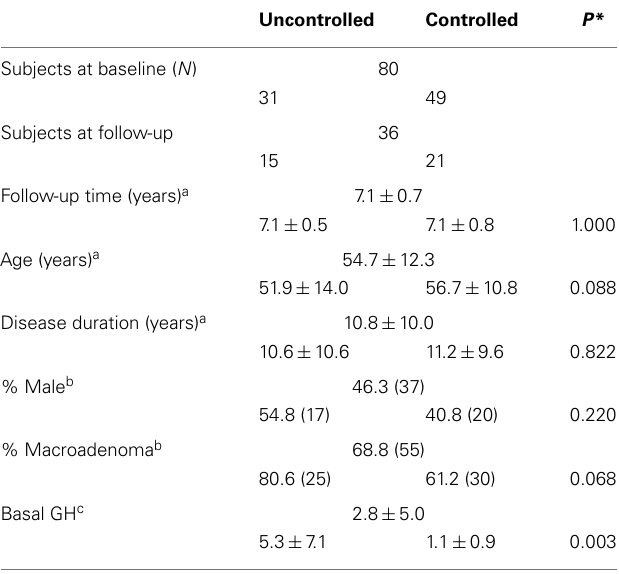
Table 1 | Demographic variables according to disease control